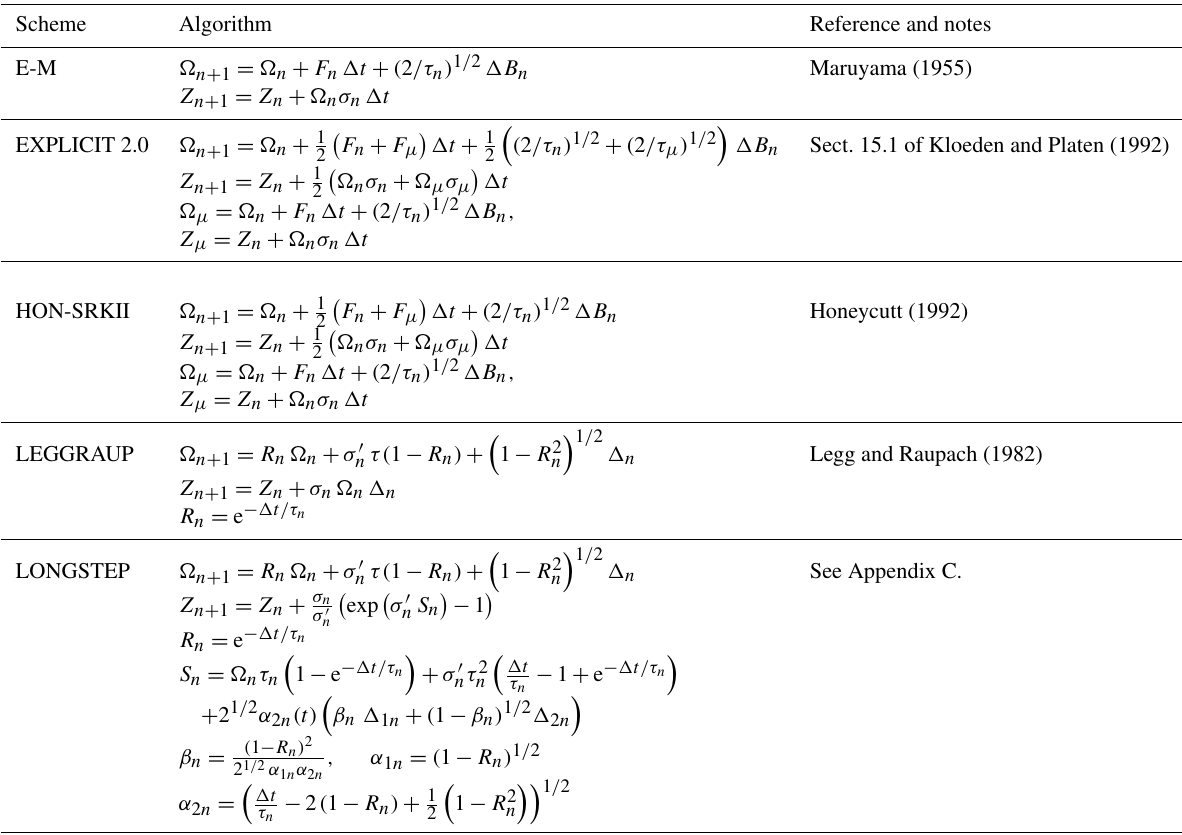
Table 2. The LPDM numerical schemes investigated in Sect. 4. Here (cid:49)t is the time step, (cid:49)B n ∼ N ( 0 ,(cid:49)t) , (cid:49) n ∼ N ( 0 , 1 ) and σ i = σ w (Z i ) , and τ n = τ(Z n ) . The drift function is denoted by F i = − (cid:127) i /τ(Z i ) + σ (cid:48) w (Z i ) where i = n,µ . Scheme Algorithm Reference and notes Maruyama